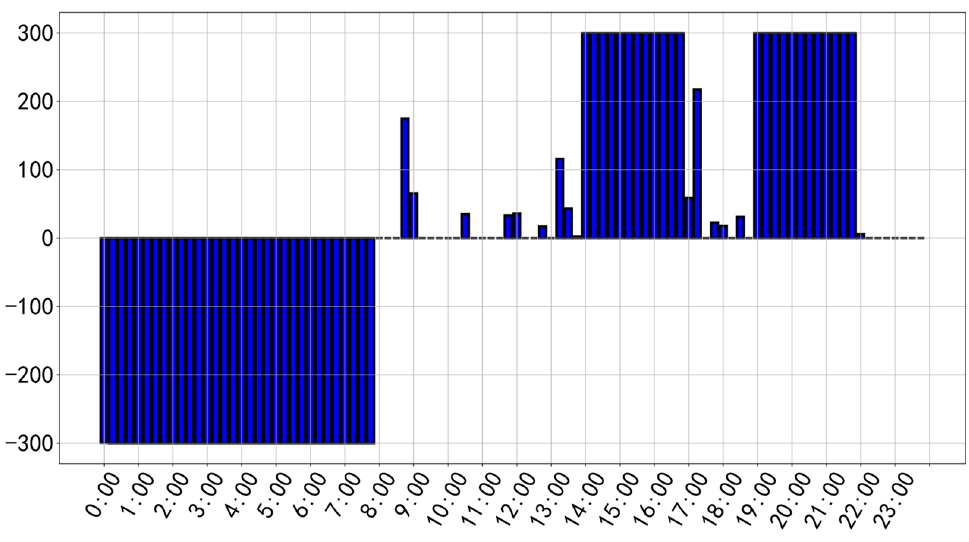
Figure 9. Typical daily energy storage charging and discharging power.